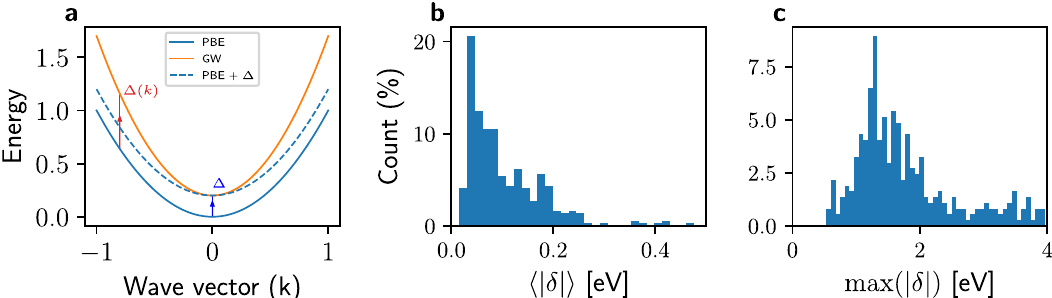
Fig. 9 Scissor operator approximation. a Illustration of the scissors operator approximation for a generic band. The G 0 W 0 correction ( Δ ) is calculated at, e.g., the Γ -point and is used to correct the energies at all every k -point. This yields the scissors shifted band structure, here labeled “ PBE + Δ ” . The actual G 0 W 0 correction at the point k is labeled Δ ( k ). b Histogram showing the mean absolute error. c Maximum absolute error ( b ) of the scissors operator approximation. In both b and c , the average (maximum) is taken over the 3 highest valence bands and 3 lowest conduction bands in each of the 370 2D materials considered in this